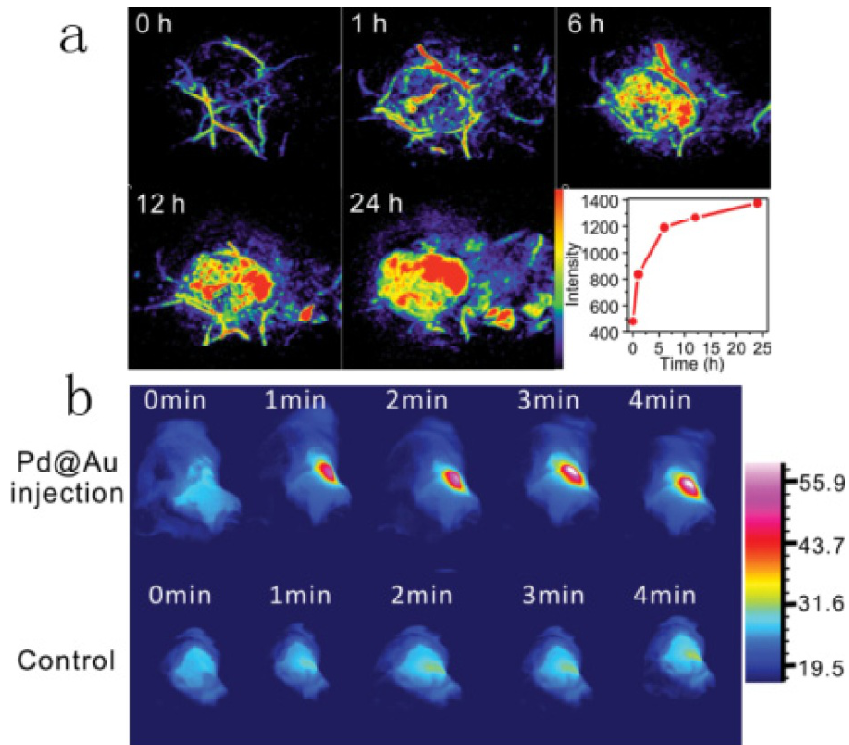
Fig. 2. (a) Photoacoustic imaging of Pd@Au-PEG in tumor sites and quantification photoacoustic signals of tumor site at different time. (b) Infrared thermal images of tumor-bearing mice with and with no Pd@Au- PEG injection under 0.5 W cm -2 808 nm laser. Reprinted with permission from M. Chen, S. Tang, Z. Guo // Adv Materials 26 (2014) 8210. Copyright 2014 WILEY-VCH Verlag GmbH & Co.KGaA,